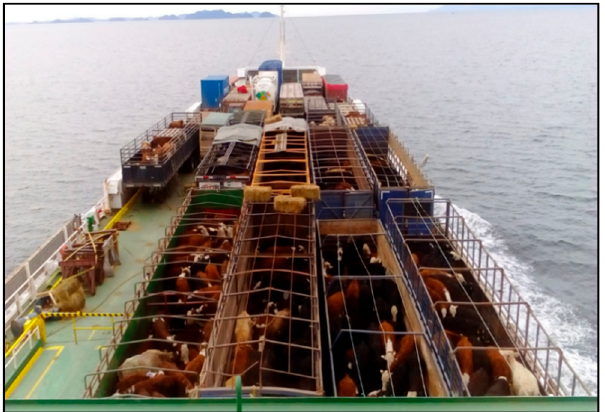
Figure 1. Transport of cattle from the Chilean Patagonia to the central-southern region of Chile using a roll-on/roll-off system for trucks.